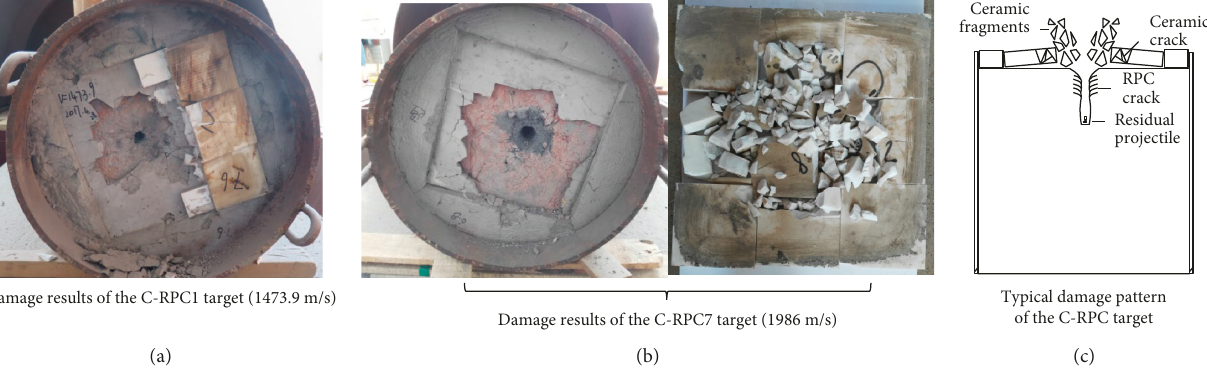
Figure 6: Damage results of C-RPC target. (a) Damage results of the C-RPC1 target. (b) Damage results of the C-RPC7 target. (c) Typical damage pattern of the C-RPC target.